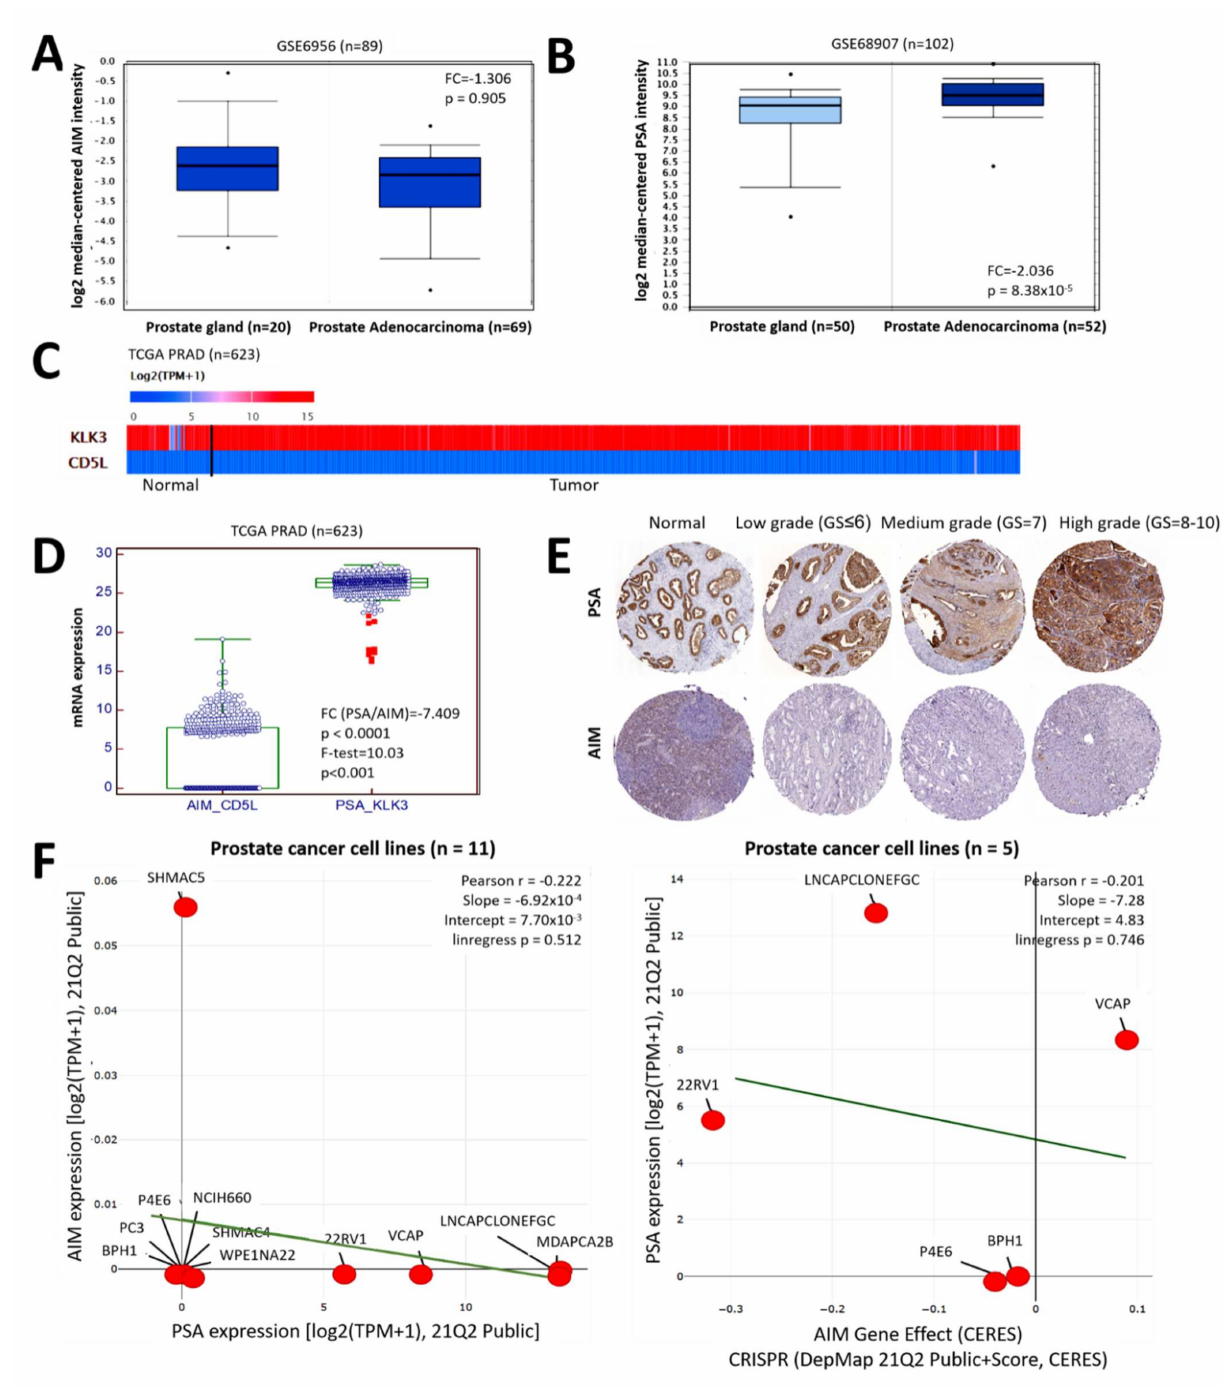
Figure 1. AIM and PSA expression levels are inversely correlated in patients with prostate cancer. Box and whisker plots of the differential expression of ( A ) AIM/CD5L and ( B ) PSA/KLK3 transcript expression in the prostate gland or prostate adenocarcinoma from the GSE6956 and GSE68907 cohort, respectively. ( C ) Comparative heatmap of the expression of KLK3 and CD5L in TCGA PRAD normal and tumor samples. ( D ) Box and whisker plots comparing the mRNA expression levels of AIM/CD5L and PSA/KLK3 in the TCGA PRAD cohort. ( E ) Representative IHC images showing the differential expression of AIM and AIM in normal prostate, low-grade, medium grade, and high-grade PCa samples from the TMU-SHH cohort. ( F ) Line and dots plot of the correlation between AIM and PSA transcript expression in prostate cancer cell lines from the DepMap Public 21Q2 dataset ( left ). Line and dot plot showing the effect of CRISPR-mediated aim gene knockout, on PSA transcript expression in prostate cancer cell lines from the DepMap Public 21Q2 dataset ( right ). TCGA, the cancer genome atlas; PRAD, prostate adenocarcinoma; IHC, immunohistochemistry; TPM, transcripts per